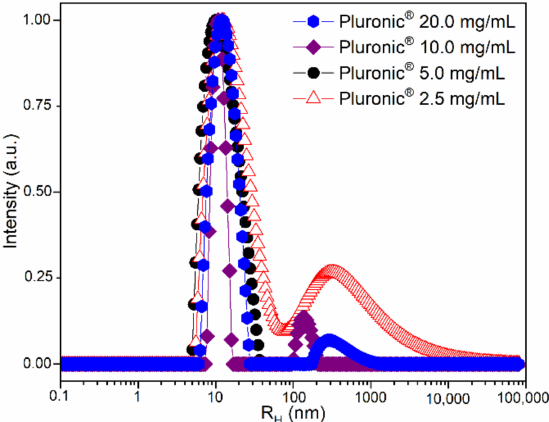
Figure 2. Size distribution of Pluronic micelles measured at 90 ◦ by Dynamic Light